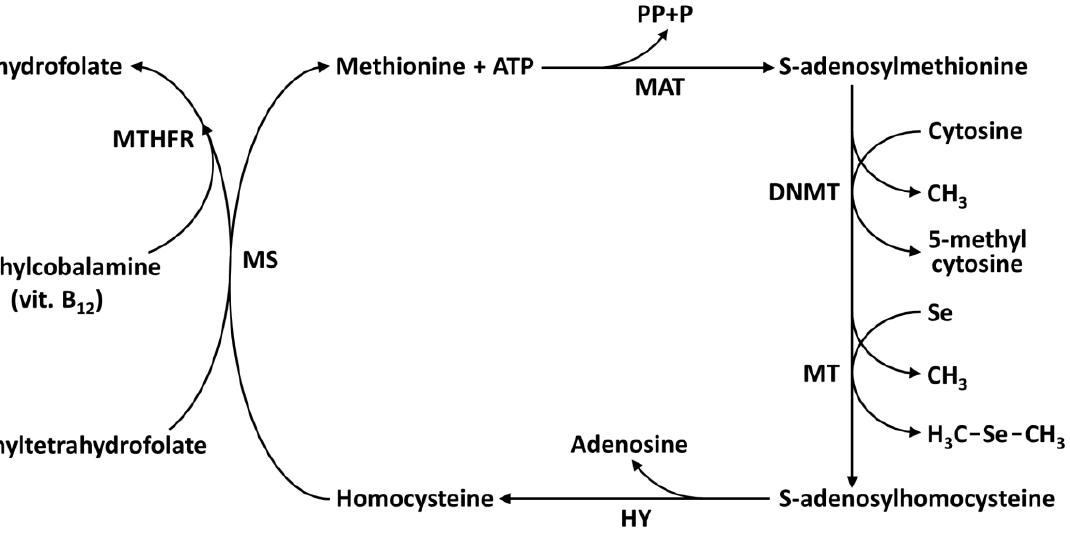
Figure 4. One-carbon metabolism cycle: DNA methylation and Se metabolism. Abbreviations: MAT: Methionine Adenosyl Transferase; MS: Methionine Synthase; MT: Methyl transferase; DNMT: DNA Methyl Transferase; HY: Hydrolase; MTHFR: Methylene Tetra Hydro Folate Reductase; PP: Pyrophosphate; P: phosphate.